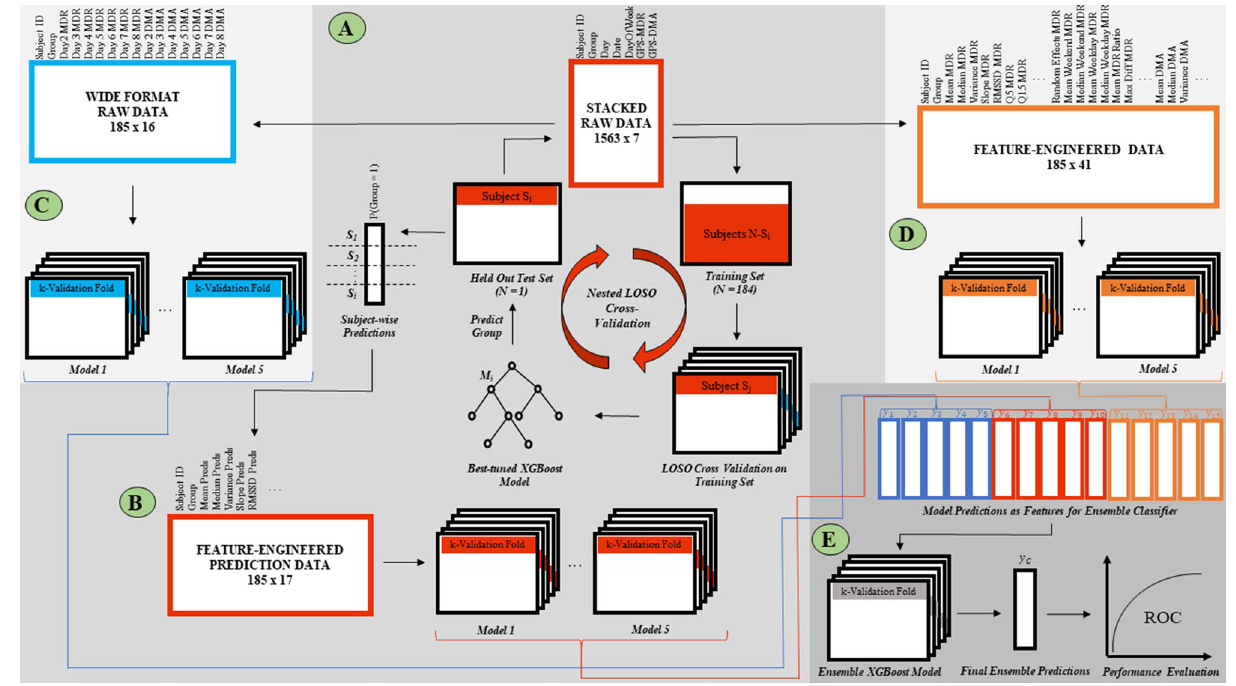
Figure 1. Analytical pipeline. Note ( A ) Long format GPS data consisting of two variables – maximum daily radius (MDR) and daily minutes away (DMA) is applied to a nested leave-one-subject-out (LOSO) cross validation machine learning pipeline to train and hyperparameter tune N = 185 independent nomothetic xgbDART models in the prediction of subject-wise group membership (1 = child abuse with PTSD; 2 = child abuse with no PTSD). ( B ) Given the stacked format of the raw data, there are multiple subject-wise prediction probabilities equal to the number of days in which GPS data was available for each individual. Thus, distributional features of these prediction probabilities were engineered to form a derived feature space used to train five lower-level machine learning models within a k-fold repeated cross validation sampling methodology. ( C ) The long format GPS raw data is converted to wide format and applied to five machine learning models with k-fold repeated cross validation. ( D ) 39 features are created from the original day-based GPS movement data. The resulting feature space is used to predict group membership with five lower-level machine learning models within a k-fold cross validation framework. ( E ) The resulting prediction probabilities of the fifteen lower-level models in ( A ), ( C ), and ( D ) are used as features in an ensemble xgbDART machine learning model using k-fold repeated cross-validation. The final prediction probabilities of this model are used to statistically